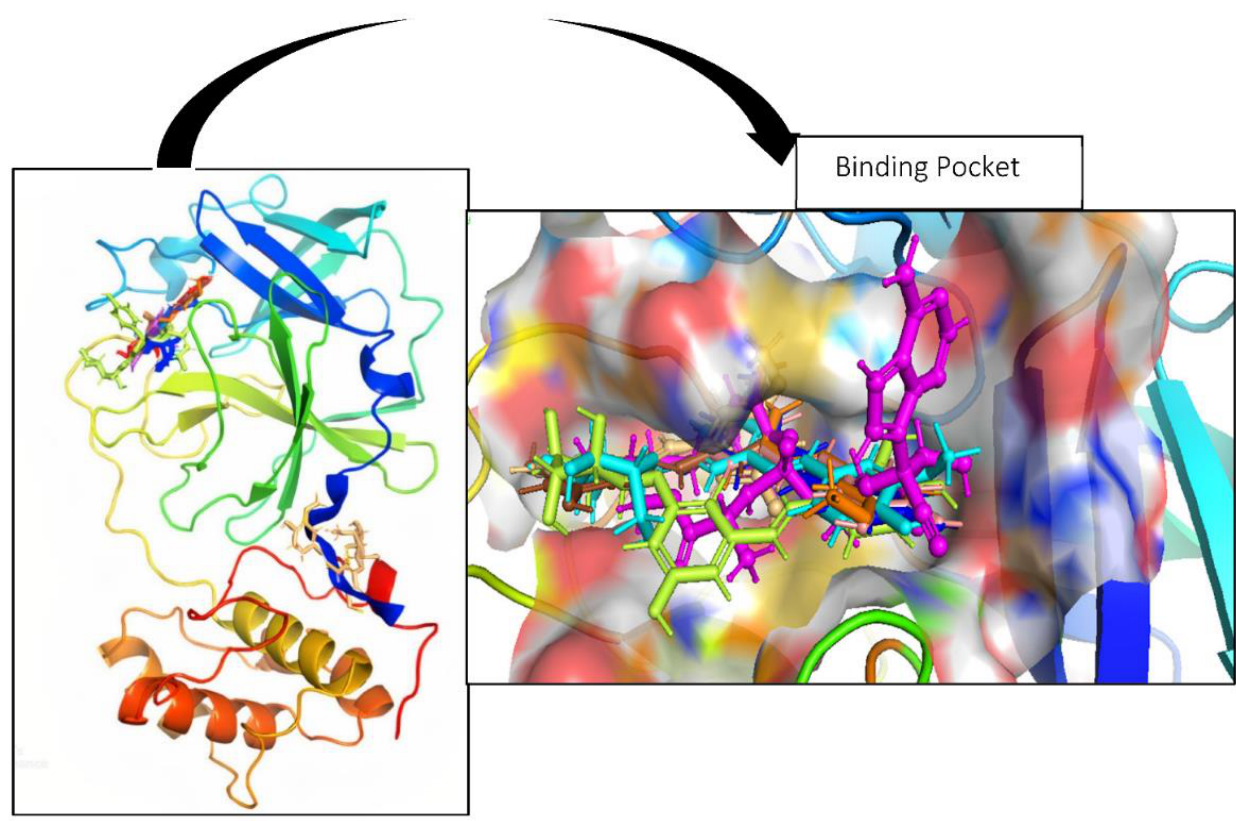
Figure 2. The structure of the Mpro protein (PDB ID: 6LU7) with docked stilbene ligands (compounds 1–7) sharing the same binding pocket. Table 2. Molecular docking results and interaction details for the reference and stilbene